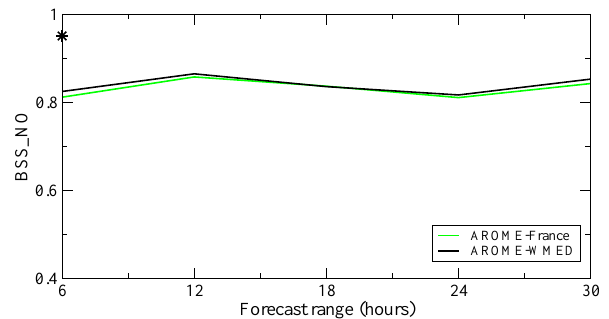
Figure 19. Brier skill score for 1h wind gusts exceeding 40kmh − 1 during the last hour as a function of forecast range during the SOP2 (01 February 2013–15 March 2013). Stars indicate where the statis- tical significance of the difference between the two models exceeds